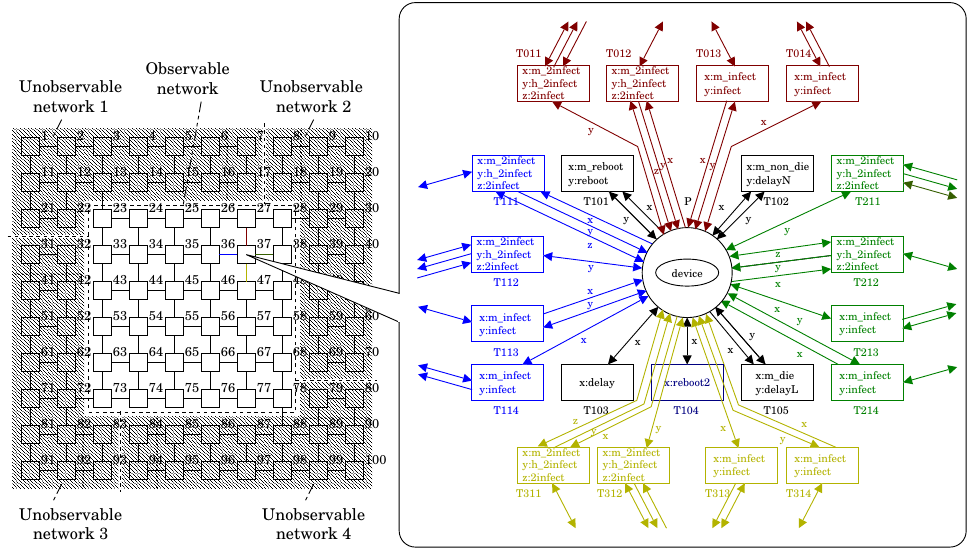
Figure 8. The network used in the hierarchical